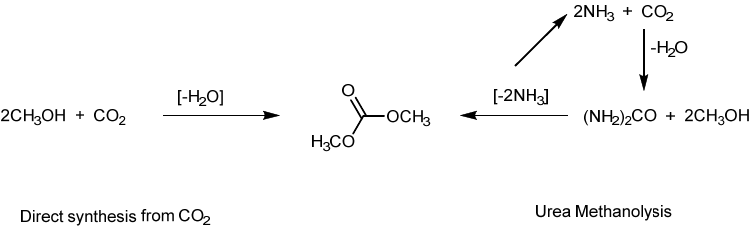
Figure 1. Synthetic routes for dimethyl carbonate (DMC) production (discussed in this review).